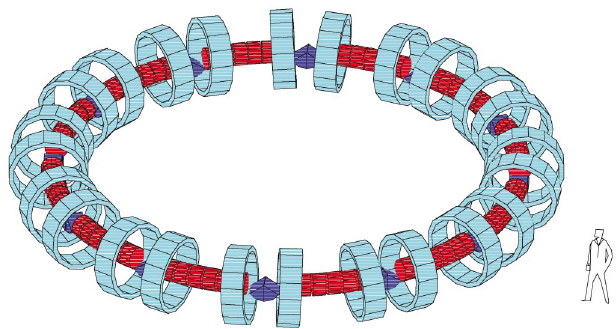
FIG. 1. (Color) GEANT drawing of an idealized RFOFO cooling ring [29]. The large cyan cylinders are solenoids, the small red cylinders are the active volume of the rf cavities, and the blue wedges are hydrogen